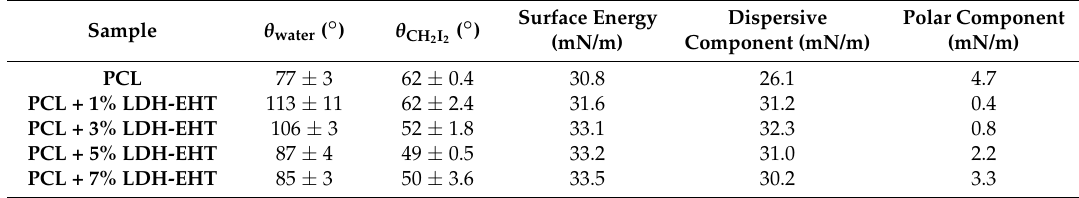
Table 3. Polar and dispersive components of the surface energy on the neat PCL and the resulting nanocomposites, from contact angles with water and diiodomethane at room temperature.